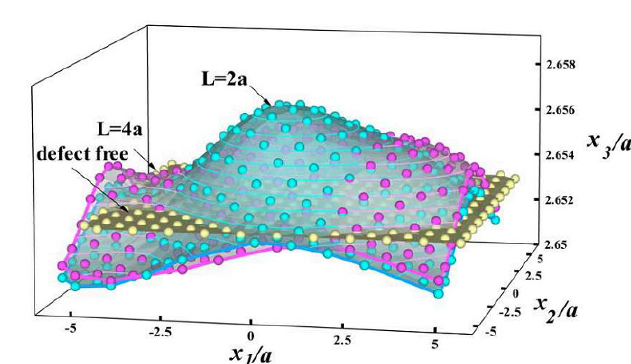
= 1 . 5 a , (b) D = 2 . 5 a , and (c) D = 3 . 5 a .